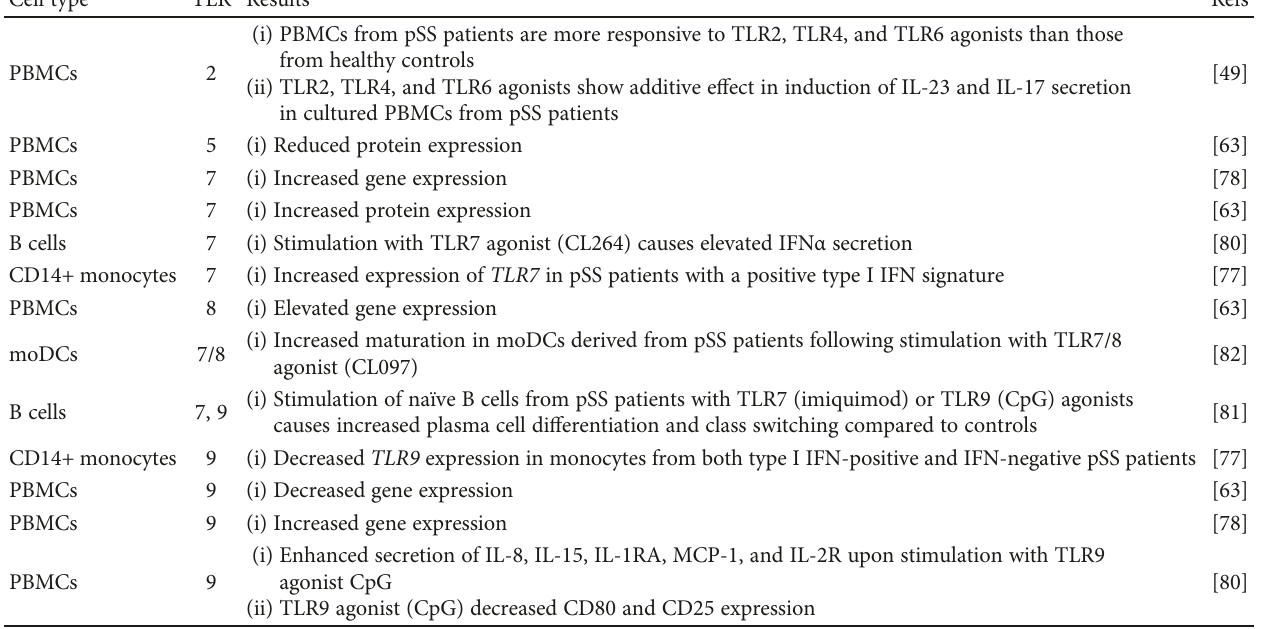
Table 3: Systemic TLR dysregulation in human SS.